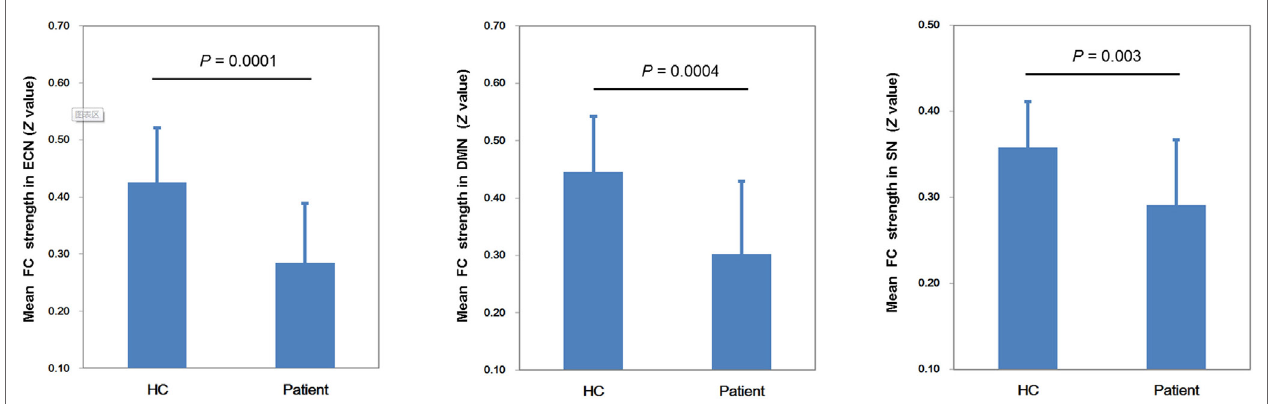
FigUre 2 | Mean network connectivity strengths for the two groups. The cirrhotic patients showed significant reductions of mean functional connectivity (FC) strength within the executive control network (ECN), default mode network (DMN), and salience network